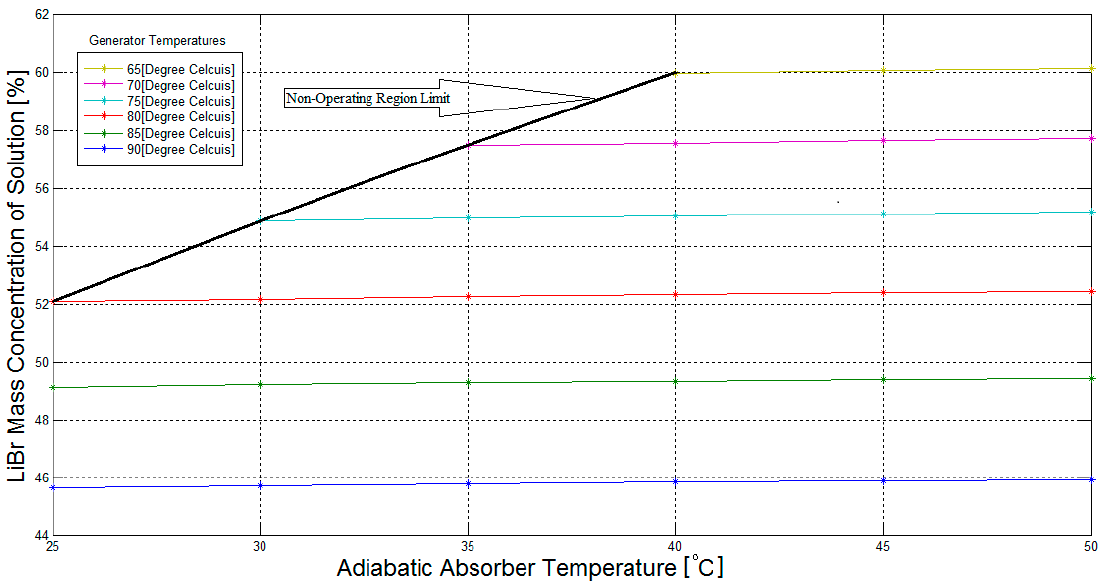
Figure 5. Graph showing the variation of the LiBr mass concentration of the solution entering the adiabatic absorber, with generator and adiabatic absorber temperatures ( T con = 35 ◦ C, T eva = 10 ◦ C ) .